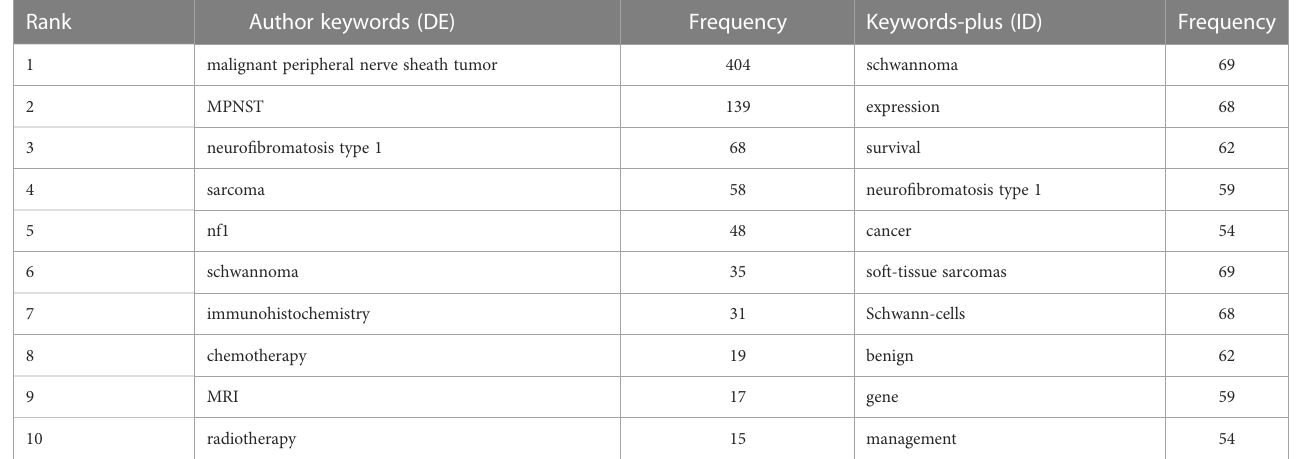
TABLE 5 Distribution of keywords based on